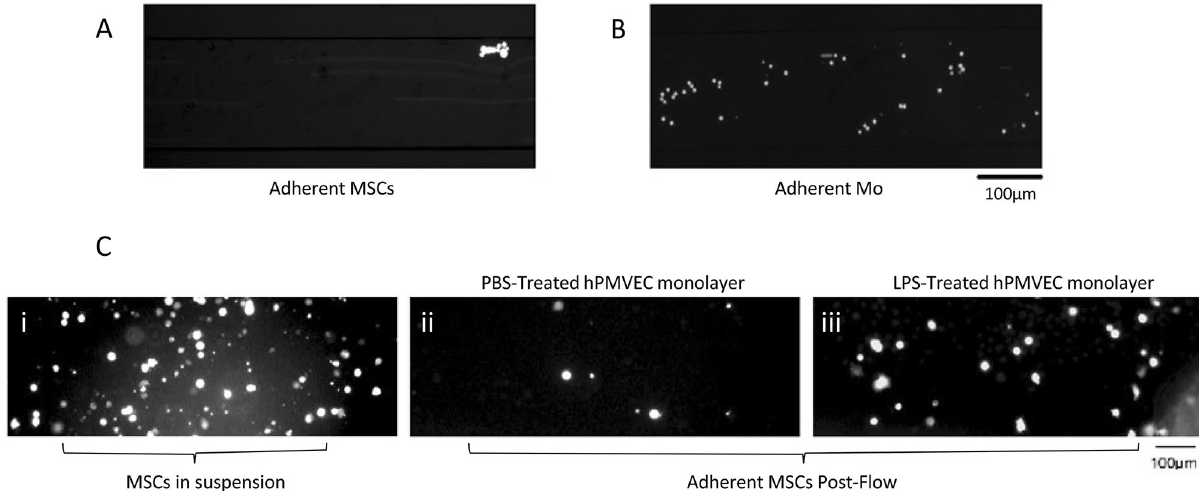
Figure 2. hPMVECs were seeded in BioFlux microfluidics channels to form monolayers and the application of 2 dyn/cm 2 pressure allowed fluorescently labelled MSCs to pass over the monolayer under shear flow. Still images from recordings indicate little to no binding of MSCs ( A ) compared to Mo control cells under the same conditions ( B ). hPMVEC monolayers were treated with PBS ( C , Panel ii) or LPS ( C , Panel iii) before MSC suspensions were passed over the layers. Flow was stopped and the cells were allowed to settle on the monolayer for 30minutes ( C , Panel i) before re-initiation of the flow. Once all cells had passed through the chamber, images were acquired of the remaining, firmly adherent cells ( C , Panels i, ii). MSC: Mesenchymal Stem Cell; LPS: Lipopolysaccharide; Mo: Monocyte; hPMVEC: human pulmonary microvascular endothelial